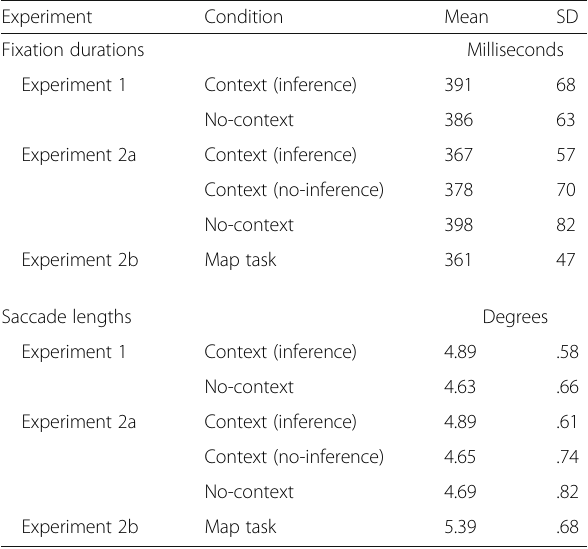
Table 1 Experiment 1 and 2 fixation duration and